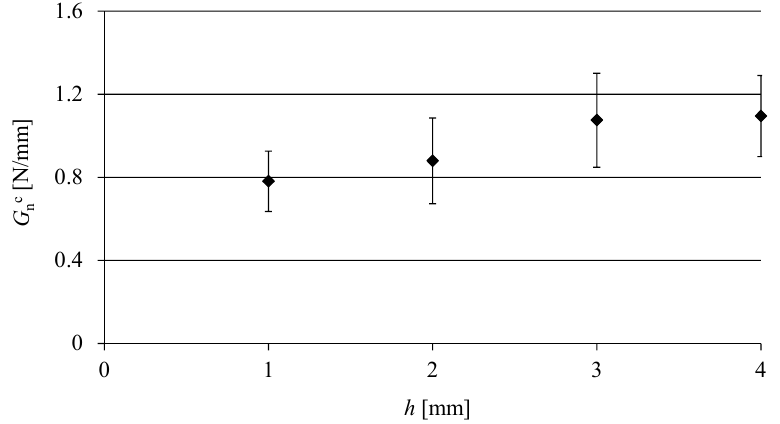
Figure 10: Average values and deviation of G n c as a function of h by the J